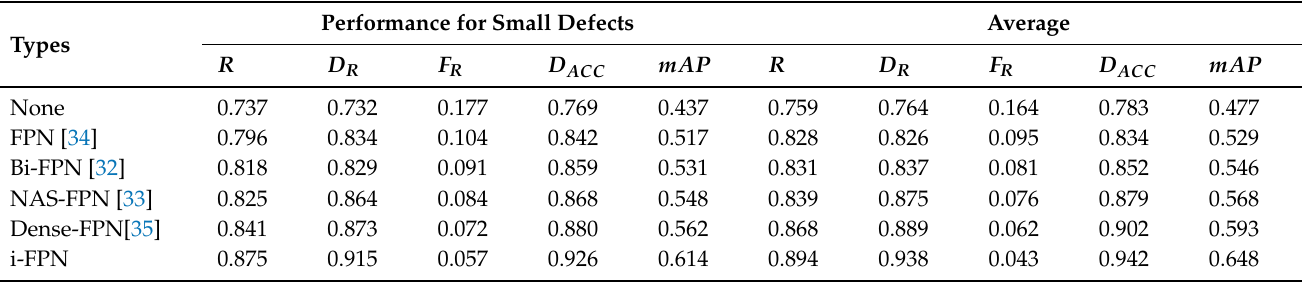
Table 3. Performance comparison between different design choices of cross-scale connection, include None, Bi-FPN, NAS-FPN, Dense-FPN, and i-FPN on